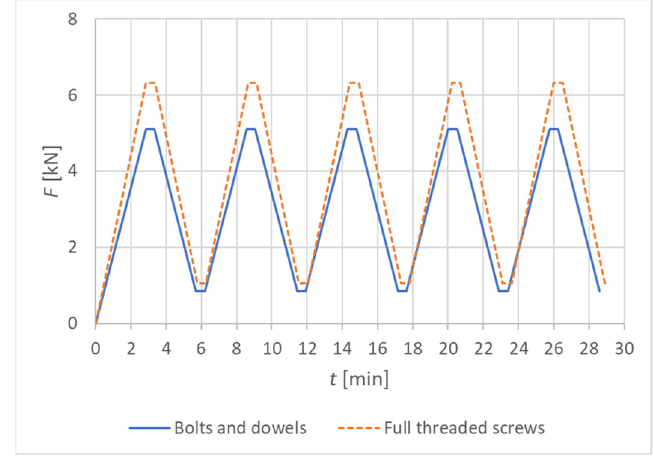
Figure 8. The course of individual experiments.